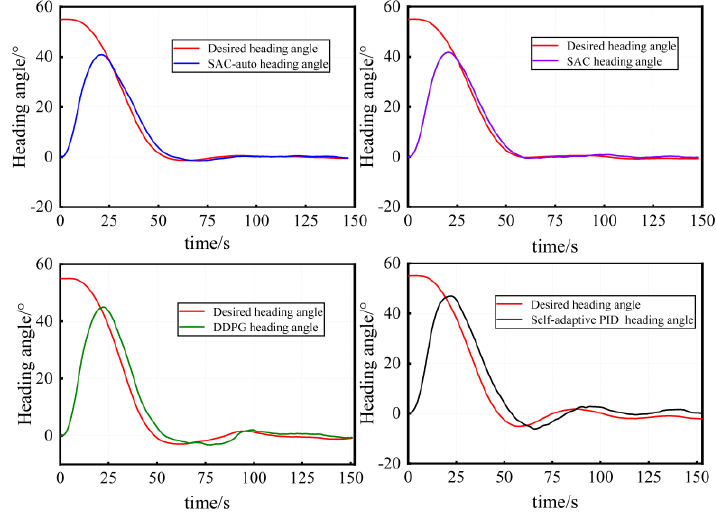
Figure 11. Path following.